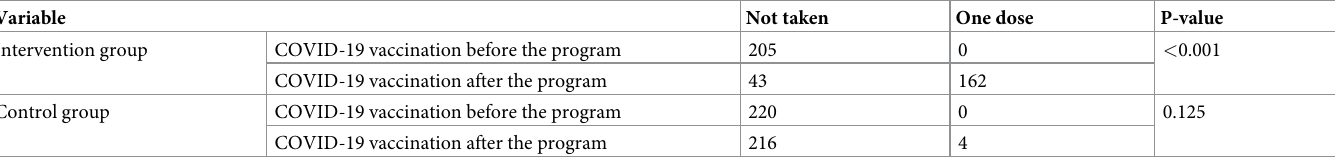
Table 4. Difference in COVID-19